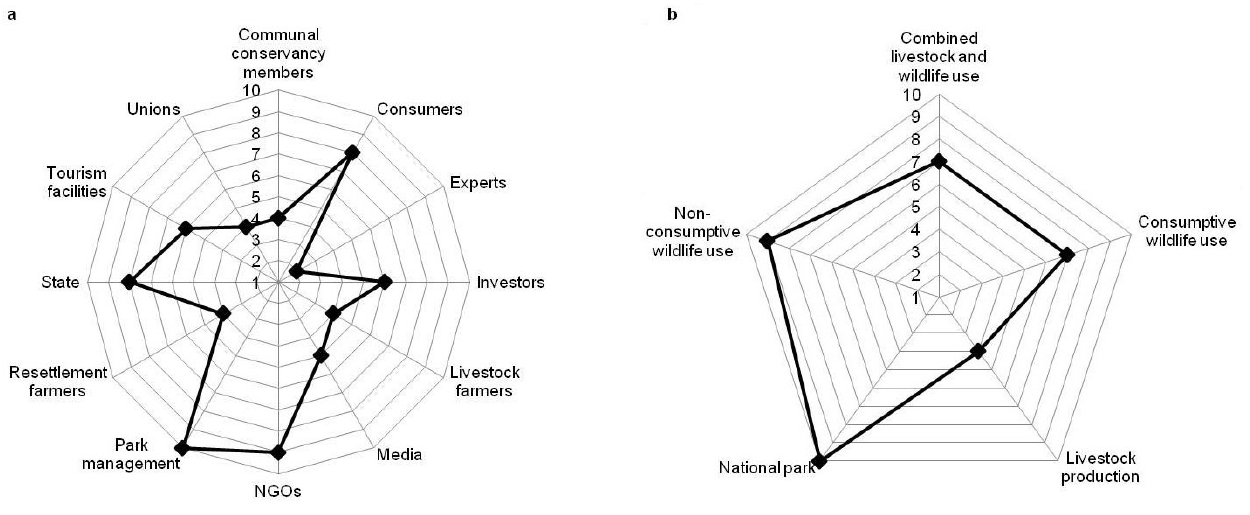
Fig. 2 . (a) Position scores of all stakeholder groups, i.e., both primary and secondary stakeholders, grouped according to stakeholder roles in the study system, i.e., conservancy members, livestock farmers, park management, NGOs, experts, etc. (b) Position scores of only the primary stakeholder groups classified according to land use, i.e., livestock production, protected area management, consumptive resource use, and nonconsumptive resource use and combined livestock and wildlife use. (Position score 1 = a strongly negative/opposed stakeholder group and 10 = a strongly positive/supportive stakeholder group, when considering their perspectives on an expanded protected area network, and their inclusion